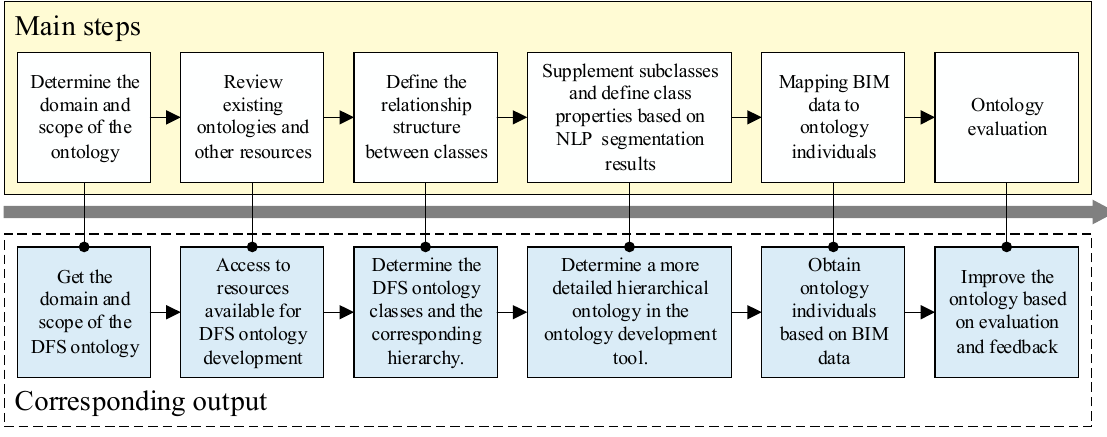
Figure 5. Seven steps to ontology development incorporating BIM and NLP.